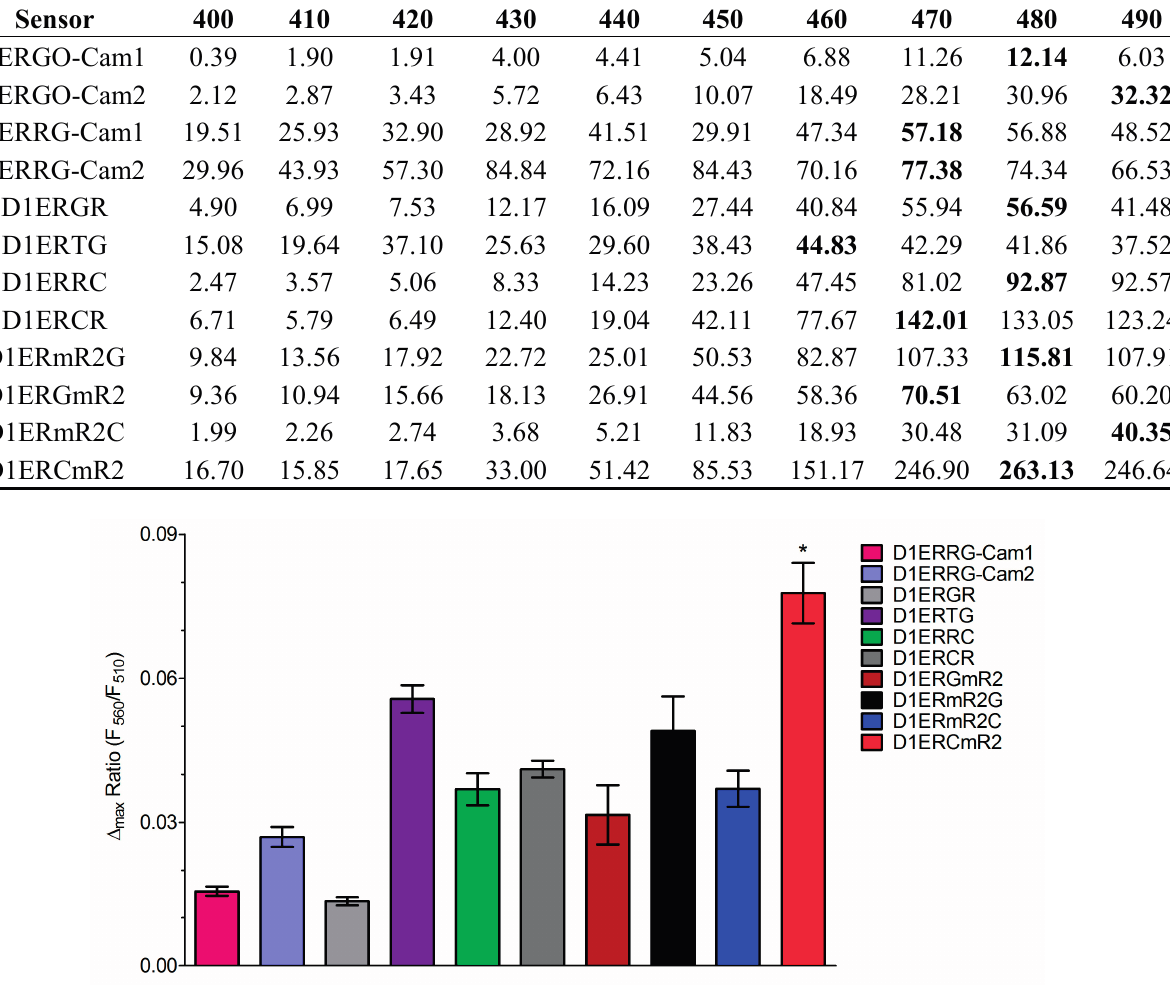
Figure 3. Column statistics of maximal ER Ca 2+ -release in HeLa cells transfected with individual GFP/RFP-based cameleons. Bars representing FRET change upon treatment with 100 µM histamine and 15 µM BHQ detected by D1ERRG-Cam1 (pink bar, n = 13), D1ERRG-Cam2 (purple bar, n = 10), D1ERGR (light grey bar, n = 4), D1ERTG (violet bar, n = 7), D1ERRC (light green bar, n = 10), D1ERCR (grey bar, n = 4), D1ERGmR2 (black bar, n = 11), D1ERmR2G (dark red bar, n = 6), D1ERmR2C (blue bar, n = 11) or D1ERCmR2 (red bar, n = 7). * P < 0.05 for D1ERCmR2 vs . all other indicators